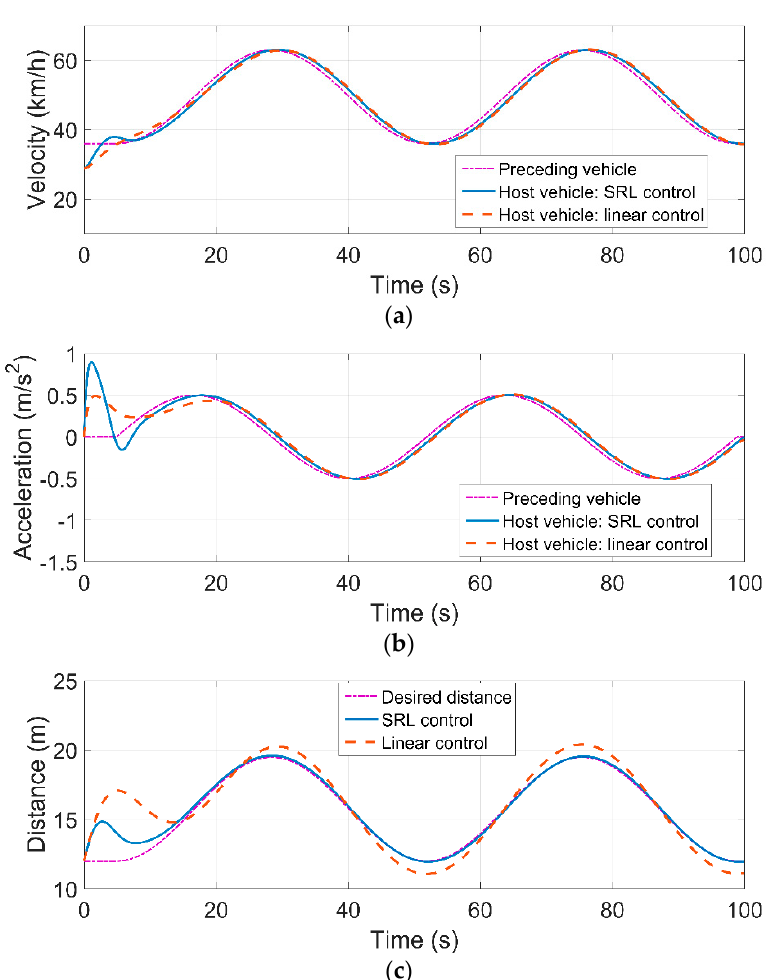
Figure 6. Simulation results with the cycle of sinusoidal velocity: ( a ) velocity, ( b ) acceleration, and ( c ) distance.